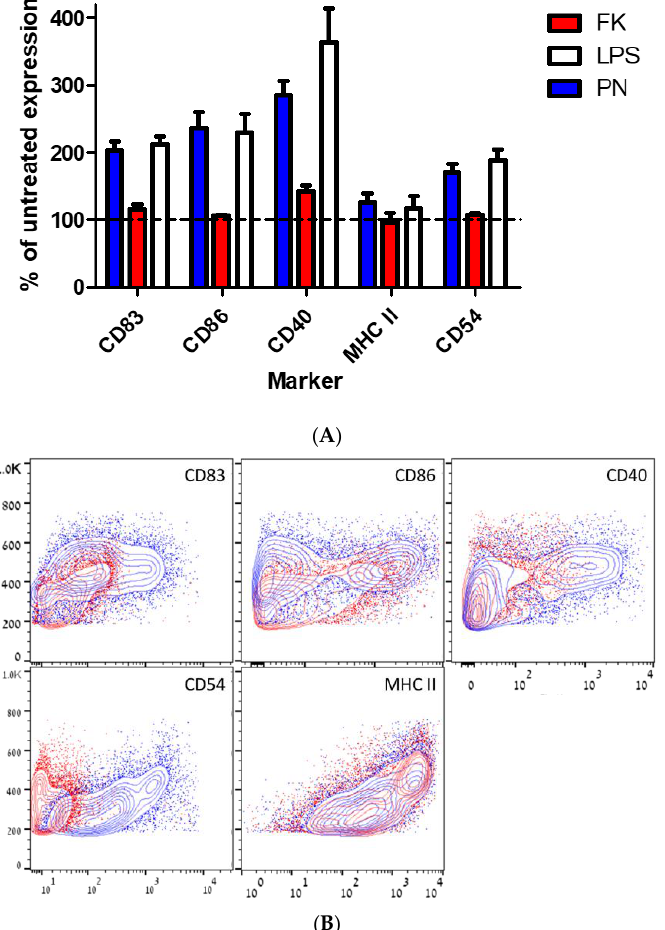
Figure 3. Early dendritic cell (DC) maturation, following incubation with neutralized bacteria. BMDCs were incubated for four hours with formalin (FK) or PN-neutralized bacteria, as indicated in the inset legend, stained for maturation markers expression and analyzed by flow cytometry. ( A ) The data are presented as the percentage of mean fluorescence intensity (MFI) change compared to non-treated cells. LPS (100 ng/mL) served as a positive control for DC maturation. ( B ) Representative dot blot presentation of CD11c + cells following 24 h of incubation with FK- (red) or PN- (blue) inactivated bacteria presenting each marker (horizontal axis) versus forward scatter.